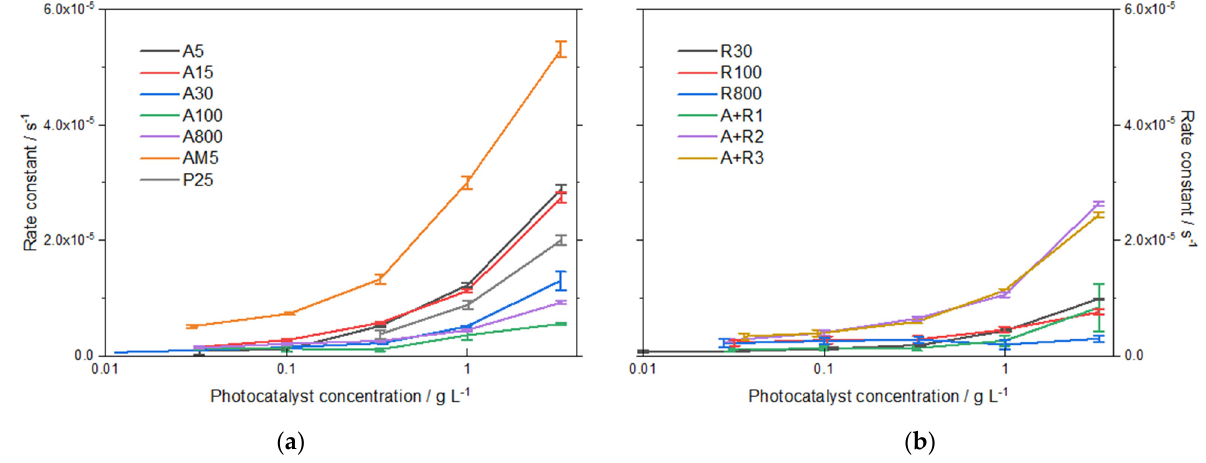
Figure 2. Rate constants of the ampicillin sorption in aqueous suspensions of all photocatalytic powders ( a , b ).